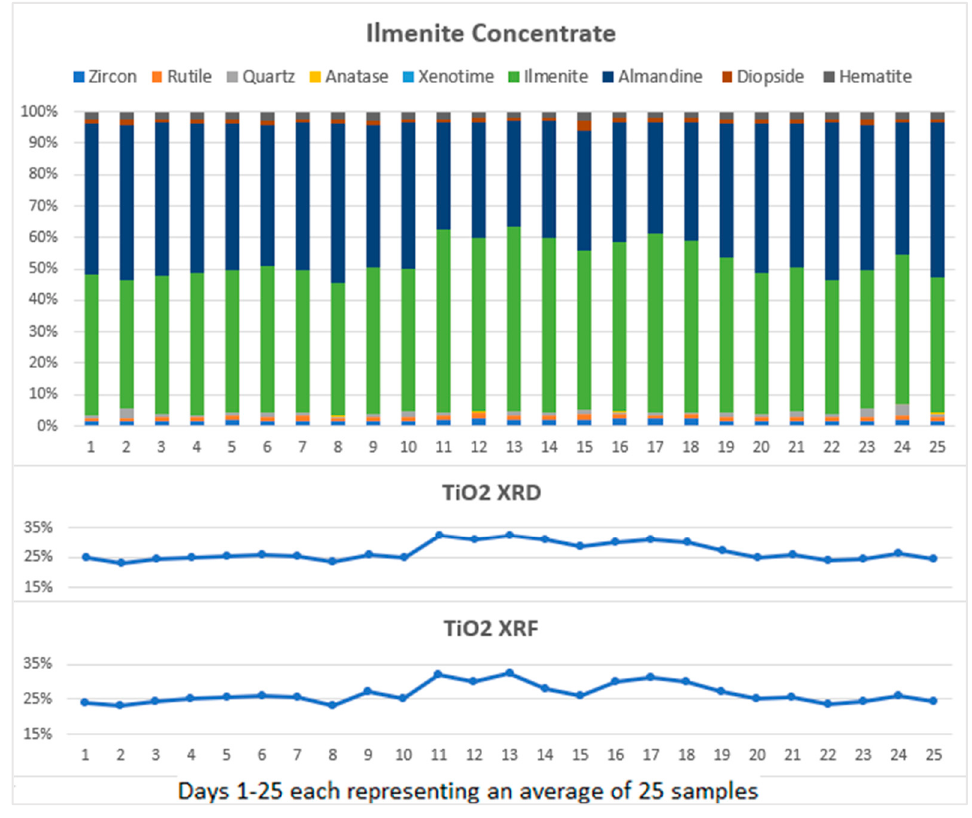
Figure 9. Variation of mineral compositions (wt%) of ilmenite concentrate, TiO 2 content (wt%) calculated from XRD results, as well as determined by XRF of 25 samples representing 25 days, ( x -axis).